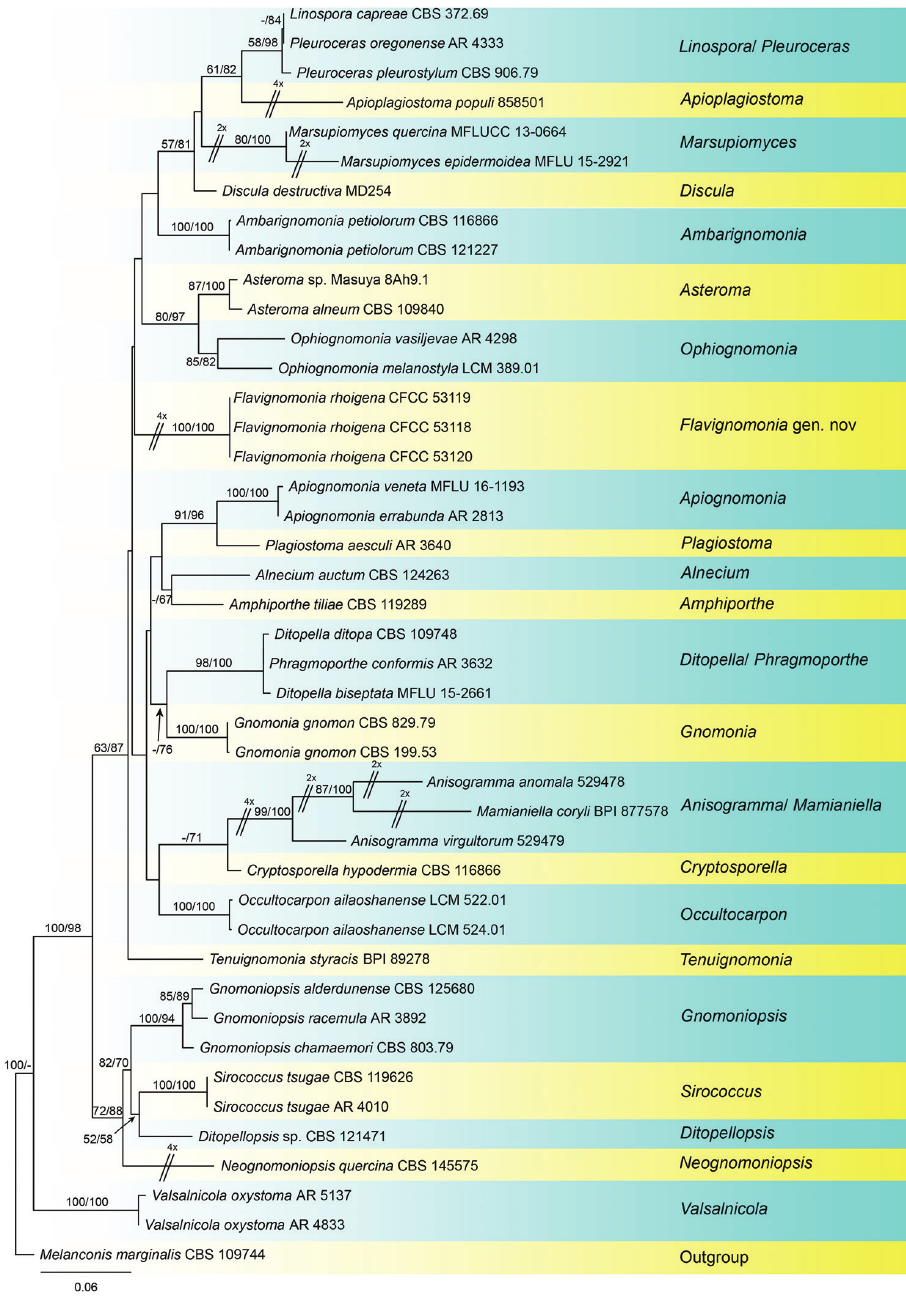
Figure 1. Phylogenetic tree based on an ML analysis of a combined DNA dataset of ITS, LSU, tef1 and rpb2 gene sequences for all genera with DNA data and some species of Gnomoniaceae. Bootstrap values ≥ 50 % for MP and ML analyses are presented at the branches. The scale bar represents the number of changes per